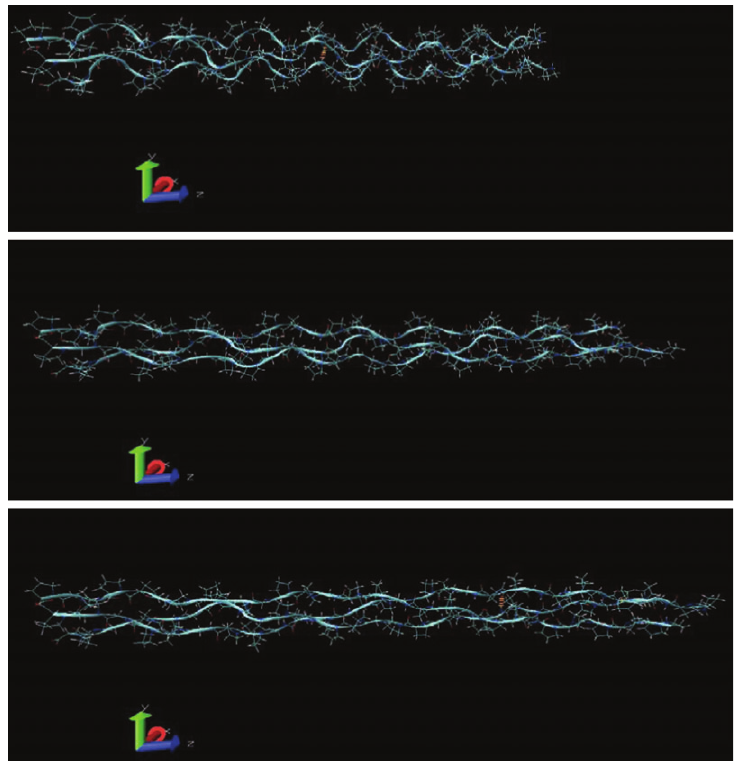
Figure 5 Snapshots showing unfolding of strained tropocollagen molecule without NaCl.